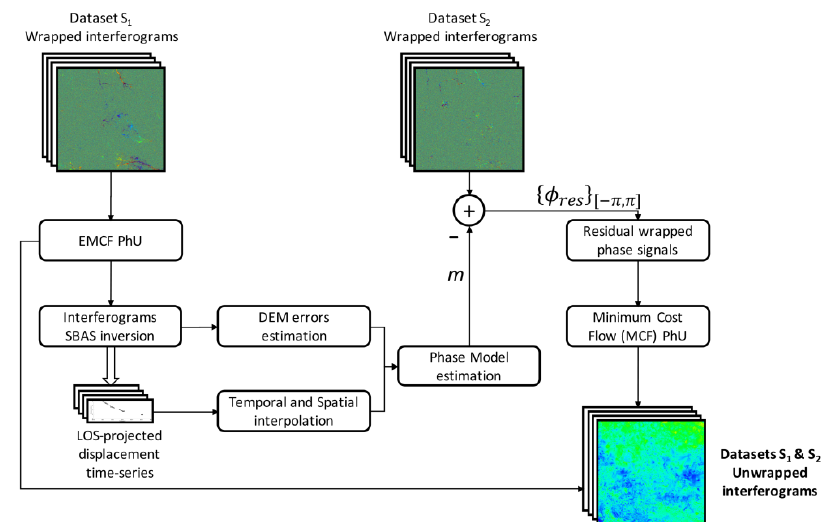
Sensors 2020 , 20 , x FOR PEER REVIEW Figure 3. Flow Chart of the modified EMCF Phase-Unwrapping (PhU) procedure. Figure 3. Flow Chart of the modified EMCF Phase-Unwrapping (PhU) procedure.